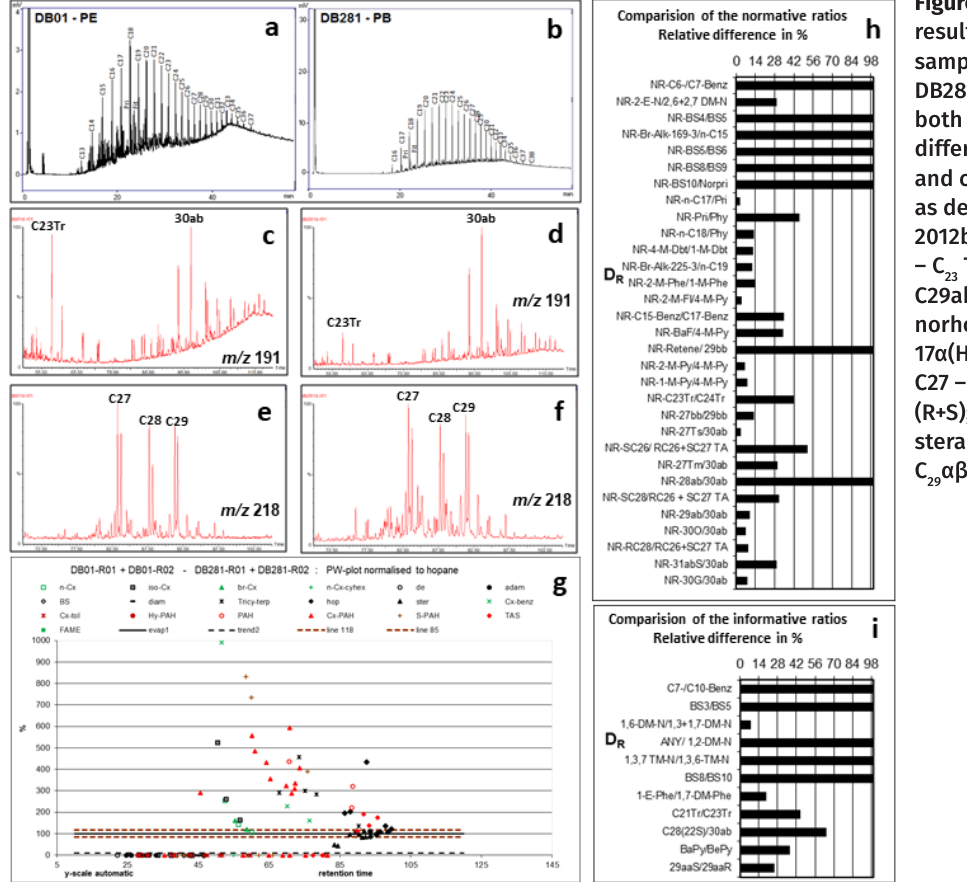
Figure 14. Combined results between samples DB01 and DB281, indicating that both samples are from different sources (DRs and compound names as described in